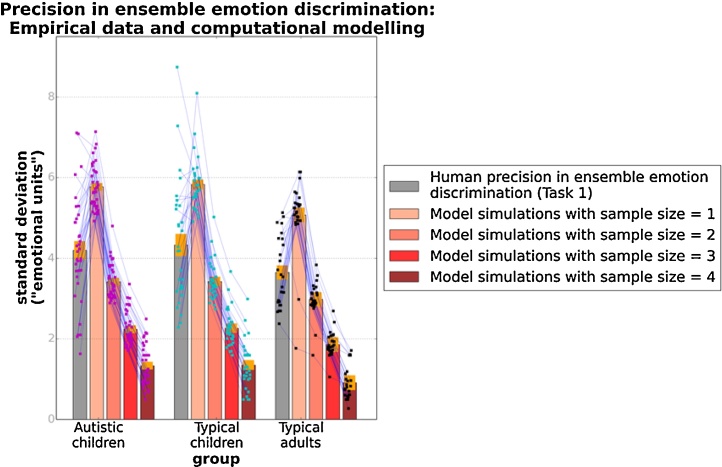
Precision in ensemble emotion discrimination: Empirical data and computational modelling. Orange bands correspond to ±1 SEM. Points superimposed on bars show individual variability, while blue lines connect empirical and simulation data for a given participant.